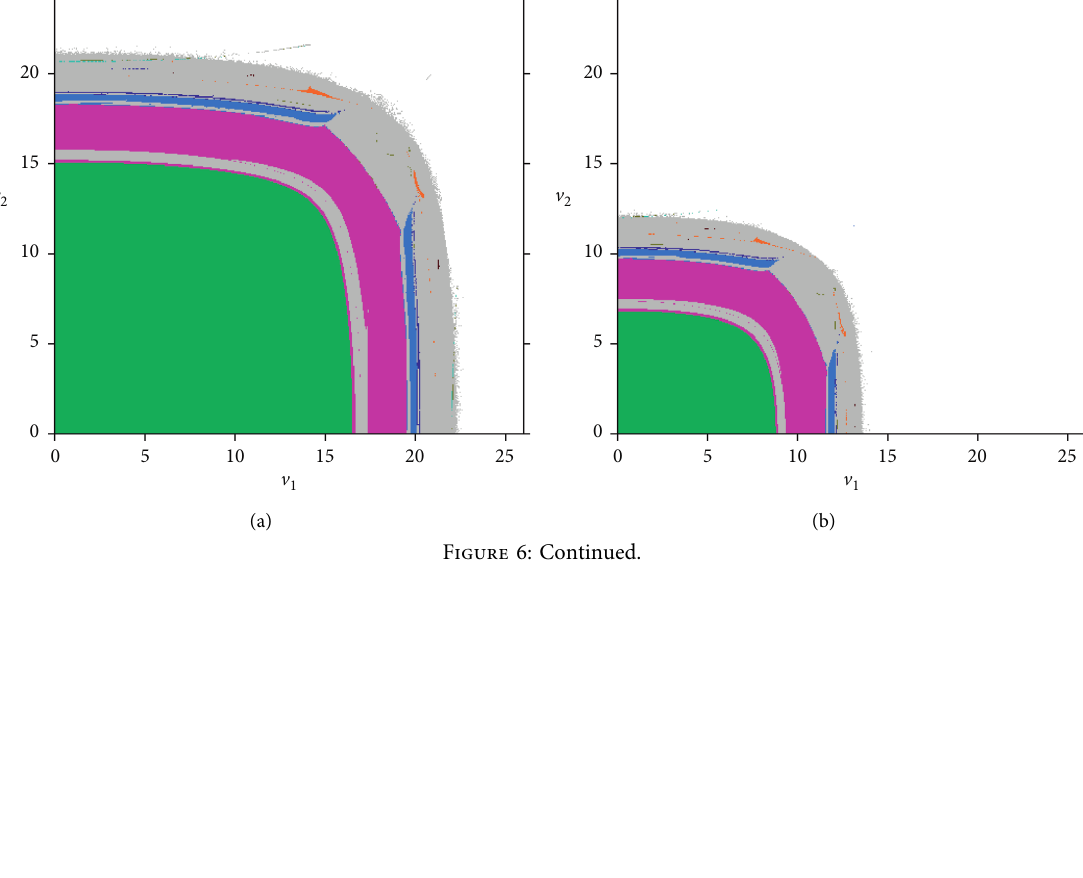
� 5. (b) R � 30. (c) R 2 2